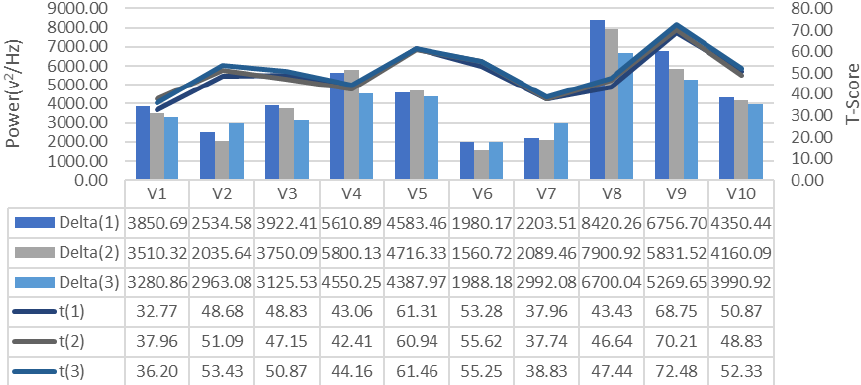
Figure 10. GDTS per round on track with Beta-High band power game performance (T-Score) relationship.